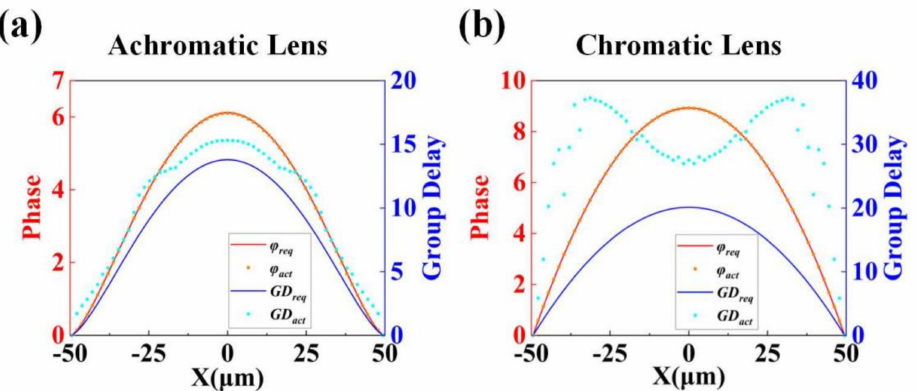
Figure 4. Theoretical phase and GD curves along the x -axis and the actual phase and GD values of the selected nanorods for ( a ) the achromatic lens and ( b ) the chromatic lens. Red curve: theoretical phase values; blue curve: theoretical GD values; red dots: actual phase values; blue dots: actual GD